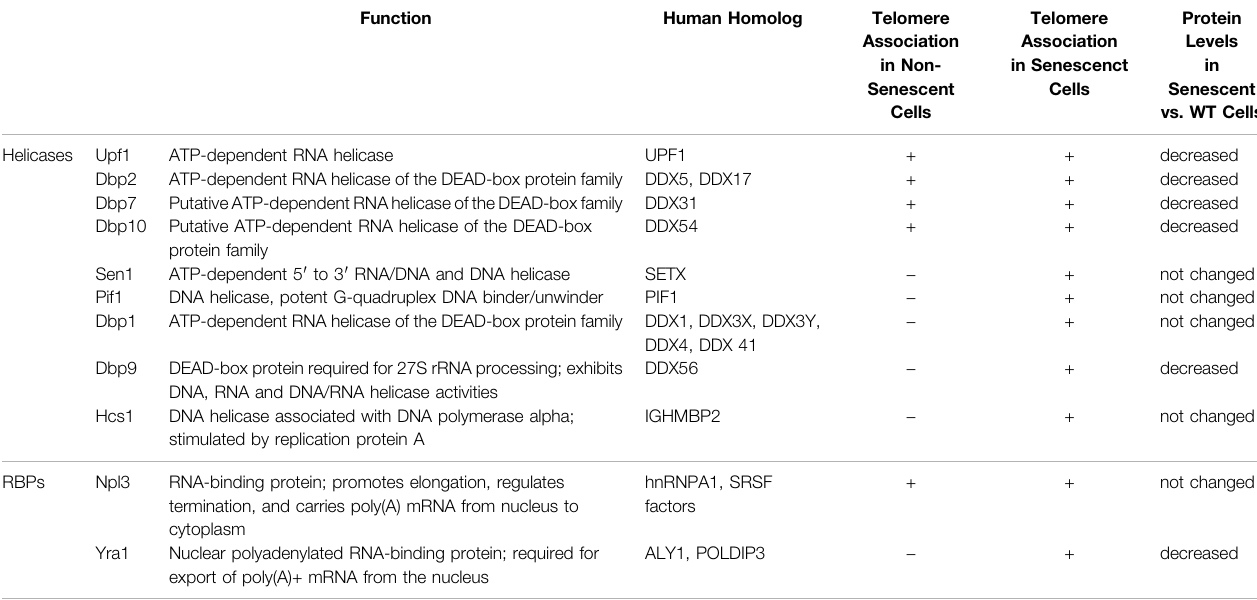
TABLE 1 | Highlighted yeast helicases and RBPs identi fi ed as telomere interactors.